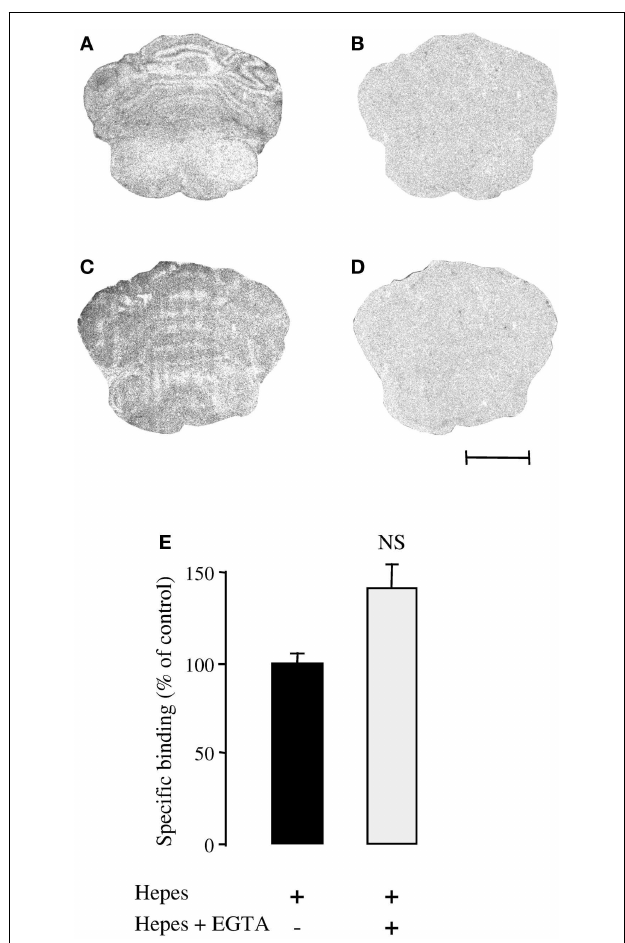
FIGURE 4 | Effect of the Ca 2 + chelator EGTA (6mM) on [ 125 I]PACAP27 binding to cerebellar tissue slices or cerebellar granule cells . (A–D) Autoradiographic visualization of [ 125 I]PACAP27 binding sites in the absence (A,C) or presence of 10 − 6 M PACAP38 (B,D) in consecutive sections of P8 rat cerebellum. Scale bar = 1.7mm. (E) Histograms showing specific binding of [ 125 I]PACAP27 in the absence (black bars) or presence (white bars) of 6mM EGTA on cultured cerebellar granule cells. EGTA, ethylene glycol-bis( β -aminoethylether)-N,N,N (cid:48) ,N (cid:48) -tetraacetic acid. NS, not significantly different from Hepes